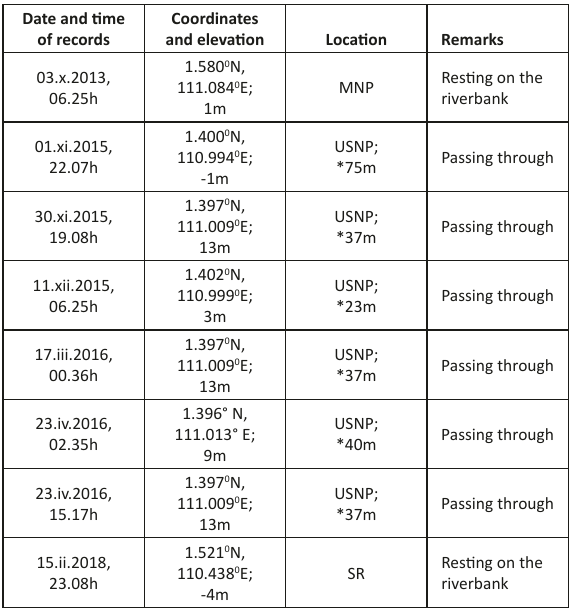
*Approximate distance of camera traps from Ulu Sebuyau